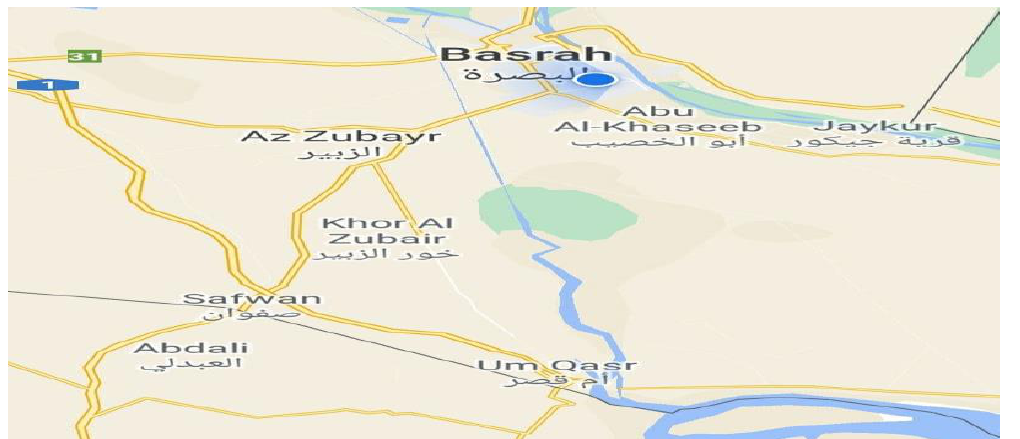
Fig. 2. Governorate of Southern Basrah Basrah's map courtesy of Google